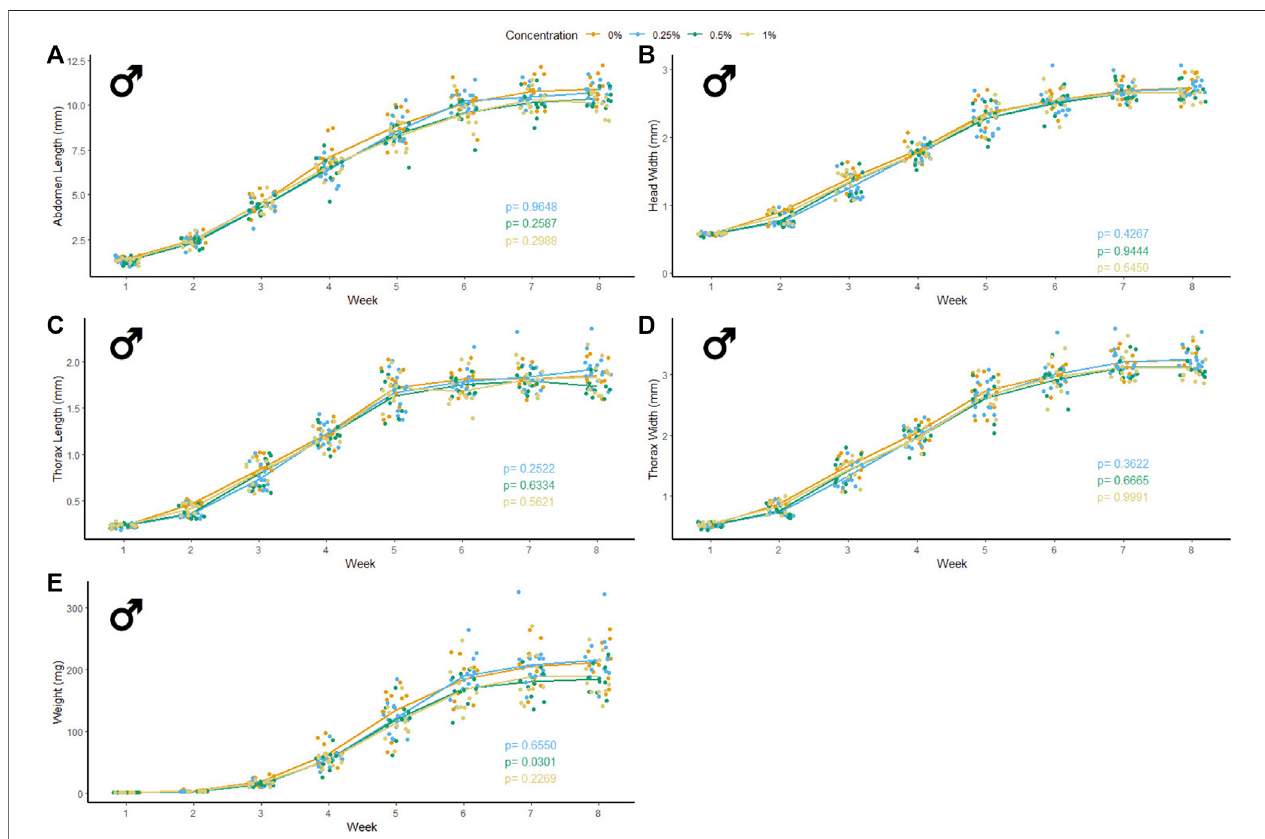
FIGURE4| Bodysizeandmassofmale Gryllodessigillatus fedadietcontainingPETmicro fi bers.Initialmeasurementsofcricketsweretakenoncecricketnymphs emerged from eggs at week1. Pointsrepresentindividual cricket measurement and lines represent meanvaluesbetween measurements. p -valuesare presented asan interaction of the concentration of PET micro fi ber with the week of growth. Each panel displays a different measure of body size with (A) = abdomen length, (B) = head width, (C) = thorax length, (D) = thorax width, (E) = weight.